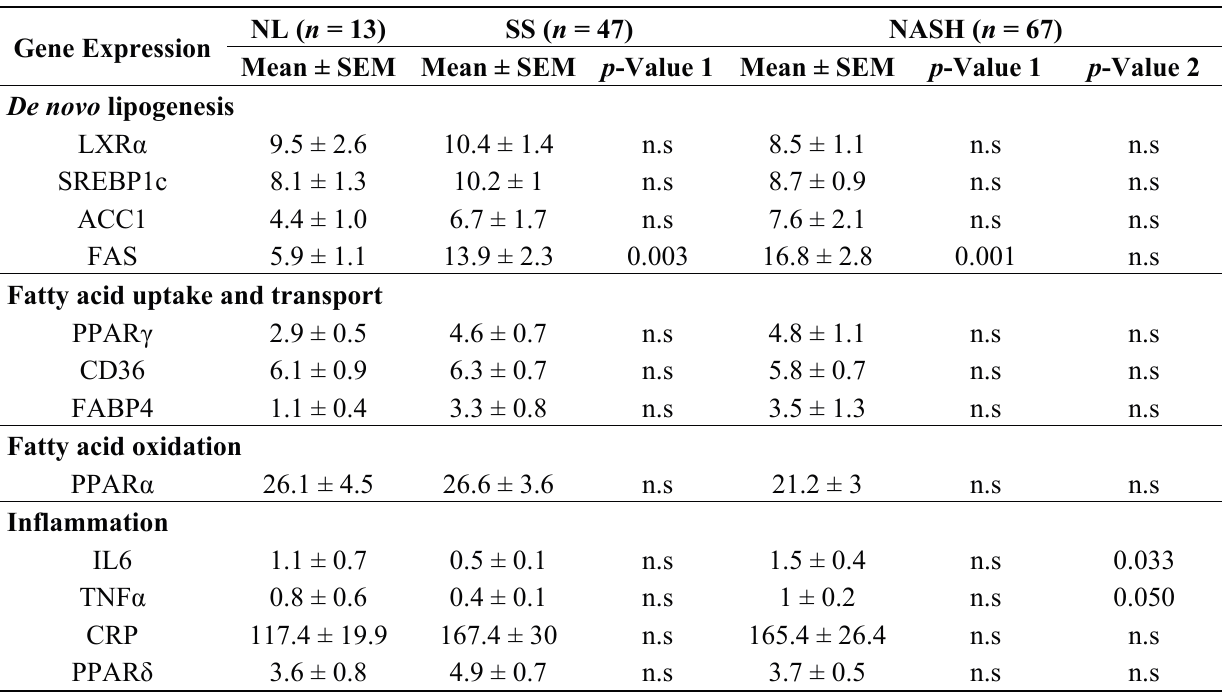
Table 2. Hepatic expression of genes related to de novo fatty acid synthesis, fatty acid uptake and transport, fatty acid oxidation, and inflammation in morbidly obese women according to the liver pathology.